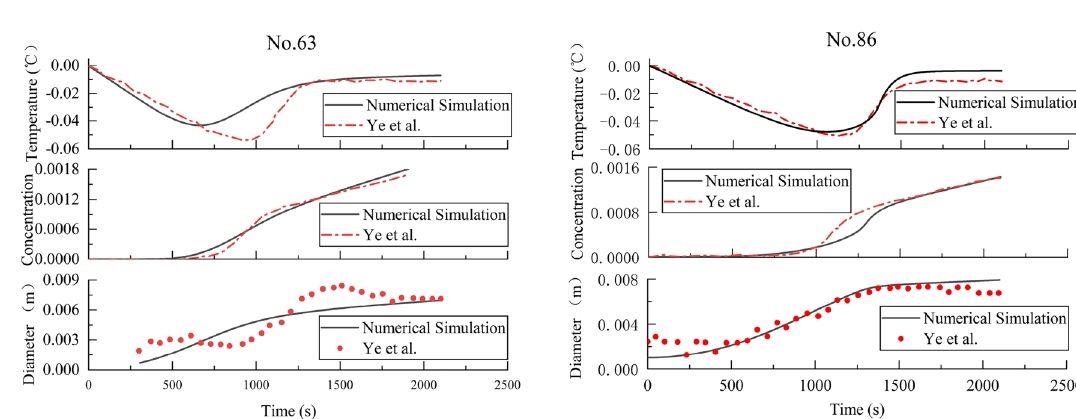
Figure 4. Water temperature, frazil ice concentration and ice crystal diameter measured in the laboratory experiment no. 63 and no. 86 by Ye et al. and as simulated by the model.